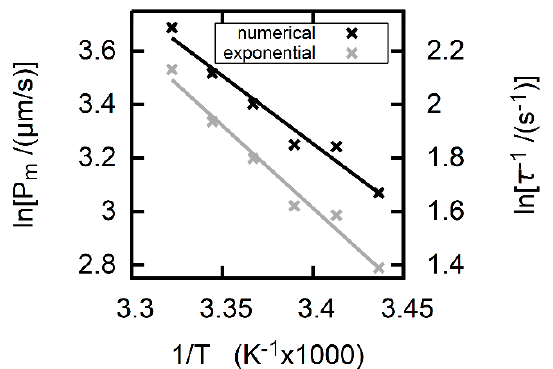
Figure 7. Arrhenius plots for the uptake of formic acid into DOPC vesicles. The temperature increased from 18 ◦ C to 28 ◦ C in steps of 2 ◦ C. The temperature dependence of P m (obtained from fitting I theor to I exp ) indicates an activation energy E A = 9.8 ± 1.0 kcal/mol. If calculated from 1/ τ (Equation (6)), E A amounts to 12.2 ± 0.9 kcal/mol (gray, right axis). The different values indicate that the time constant τ of an exponential fit to I theor is not proportional to P m , and thus Equation (6) cannot be used to calculate P m . The traces and fits are shown in Figure S4. The external concentration of sodium formate was equal to 20 mM. For the remaining experimental conditions please see the legend to the lower panel of Figure 4.